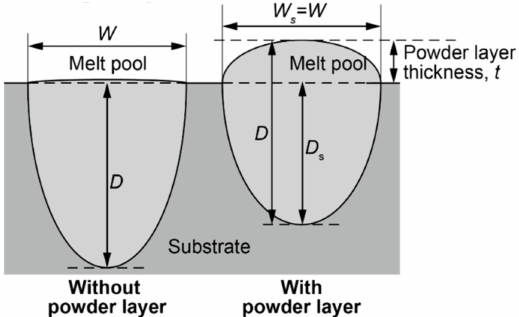
Figure 3. Relationship between melt pool dimensions with and without the powder